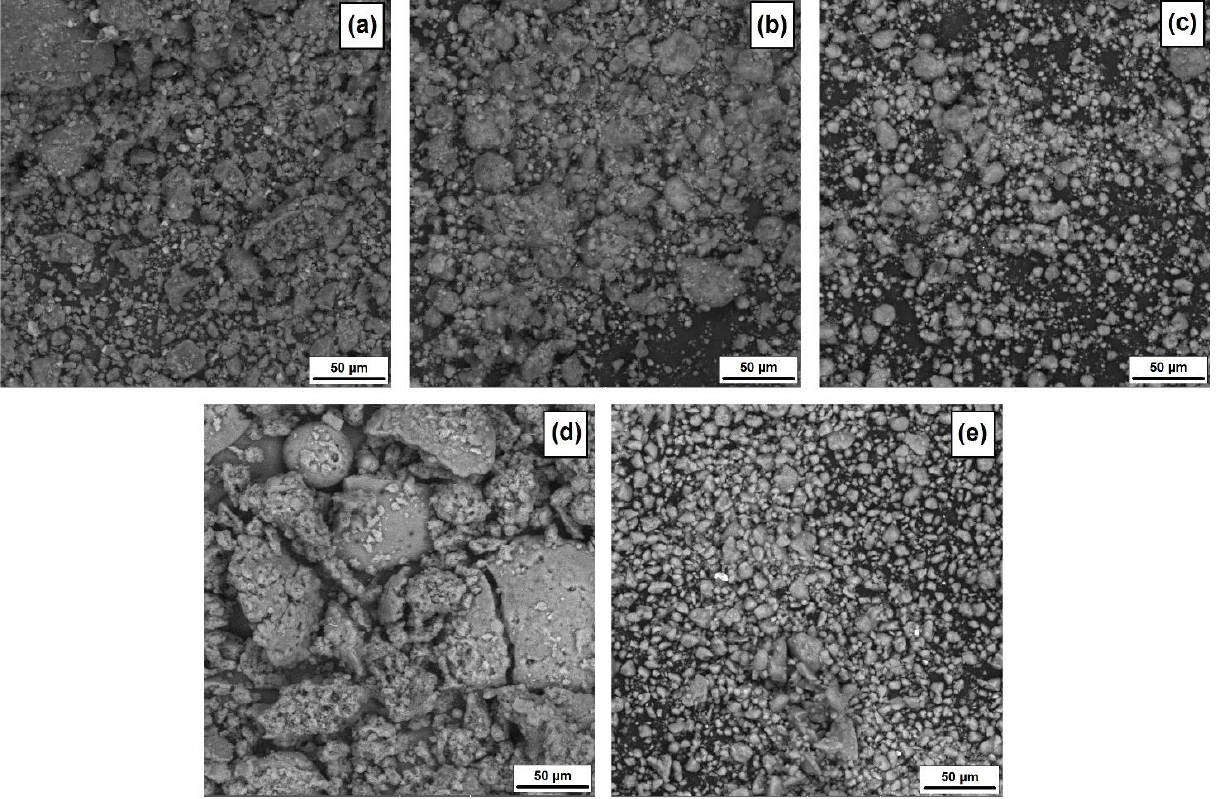
Figure 1. SEM images of halloysite – lignin hybrid materials: 1:5 wt/wt ( a ), 1:1 wt/wt ( b ) and 5:1 wt/wt ( c ) and pristine components lignin ( d ) and halloysite ( e ).